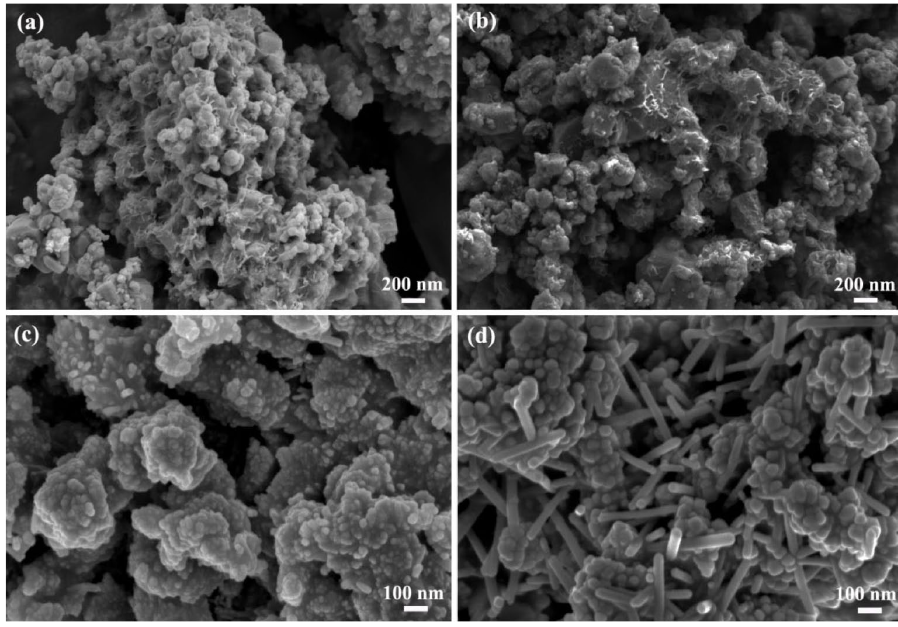
Fig. 7 SEM images of the as-synthesized HfB 2 powders after oxidation tests at various temperatures in air: (a) 773, (b) 873, (c) 973, and (d) 1073